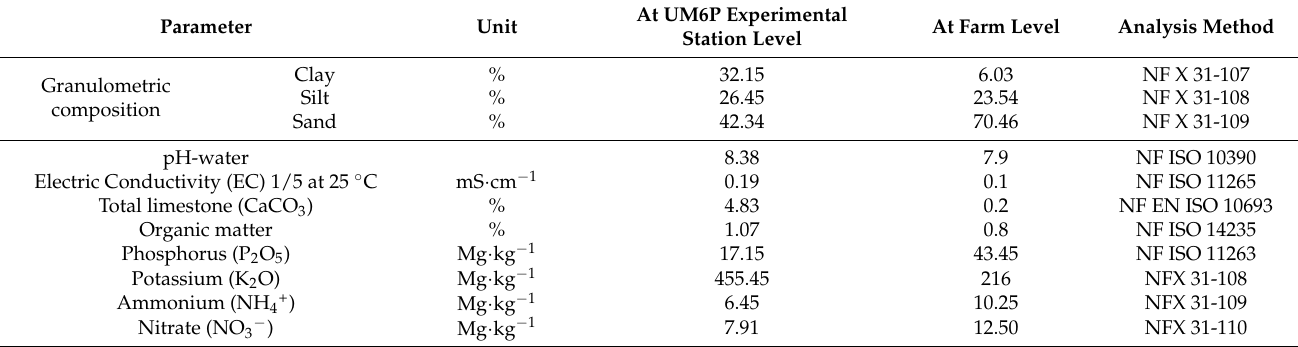
At UM6P Experimental At Farm Level Analysis Method Station Level